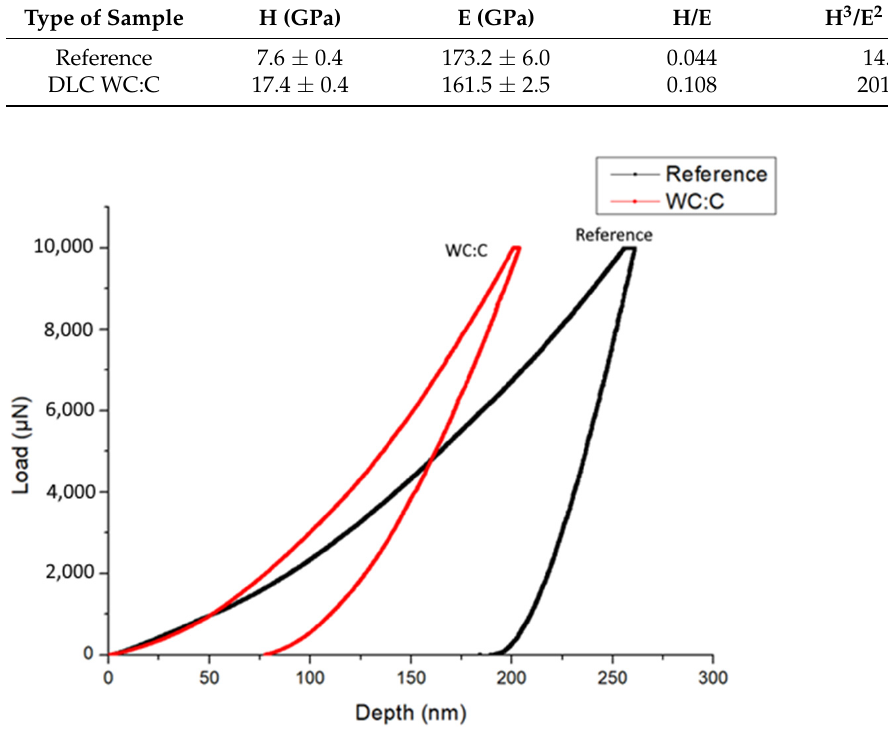
Figure 6. Nanoindentation curves of the WC:C coating (red line) and reference AISI 316-L (black line) (10 mN).